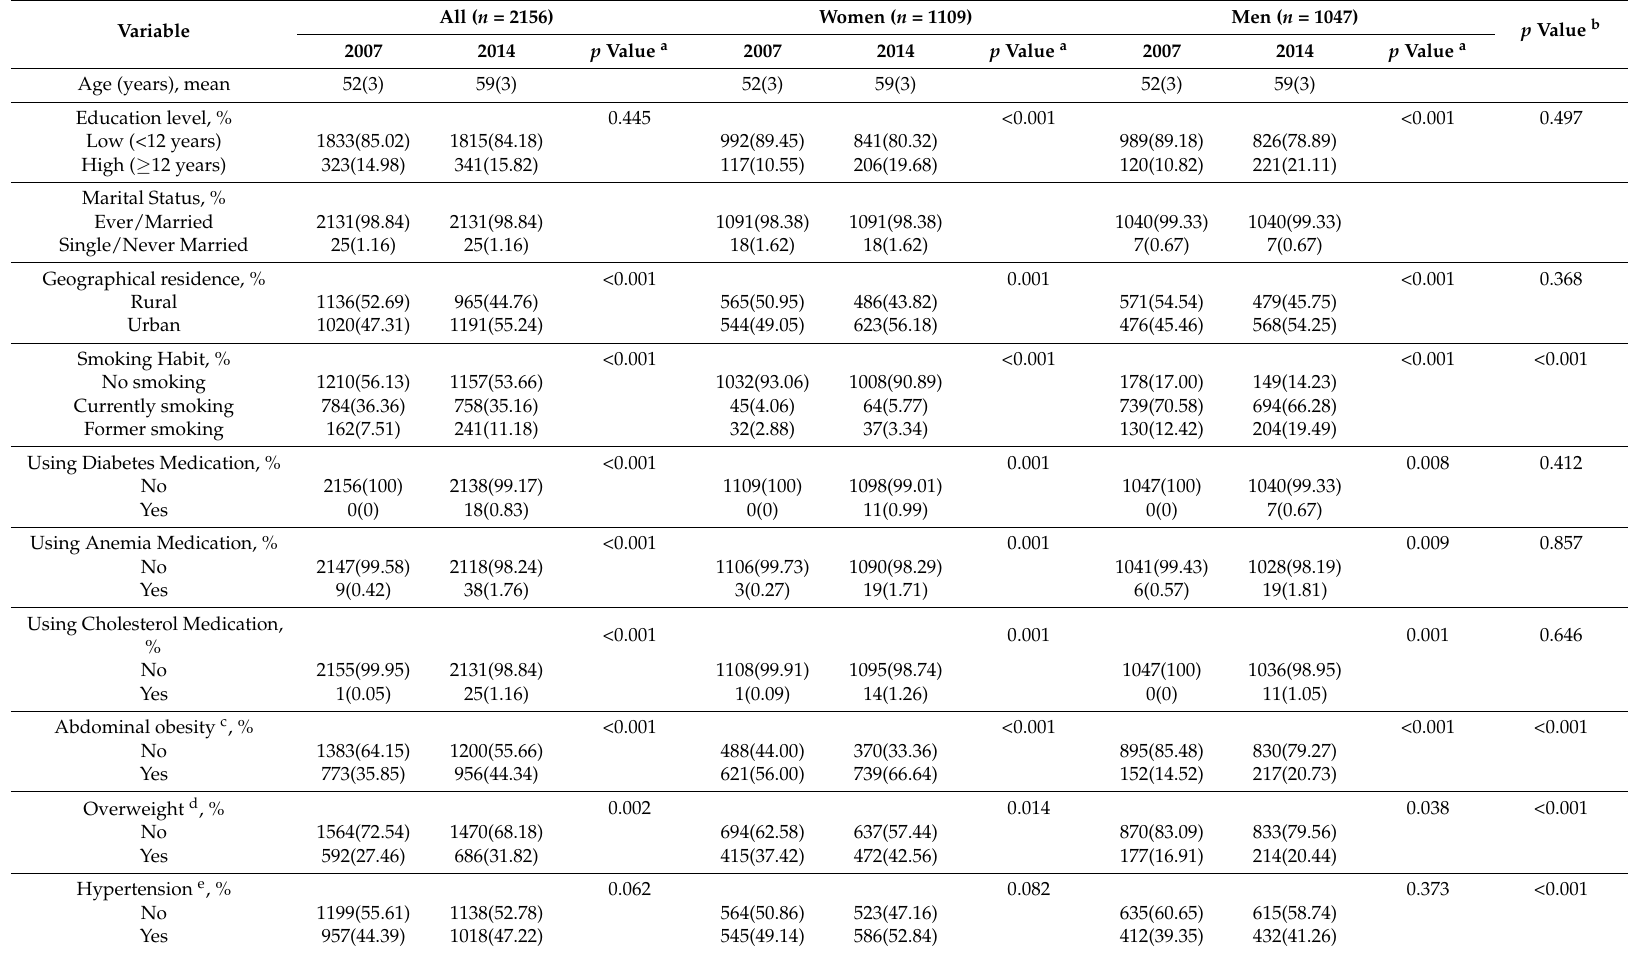
Table 1. Characteristics of